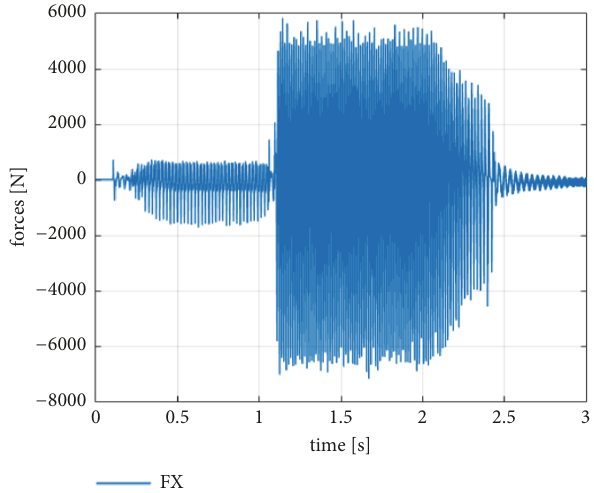
Figure 32: Predicted rotor horizontal forces at DE node during a combined landing test.